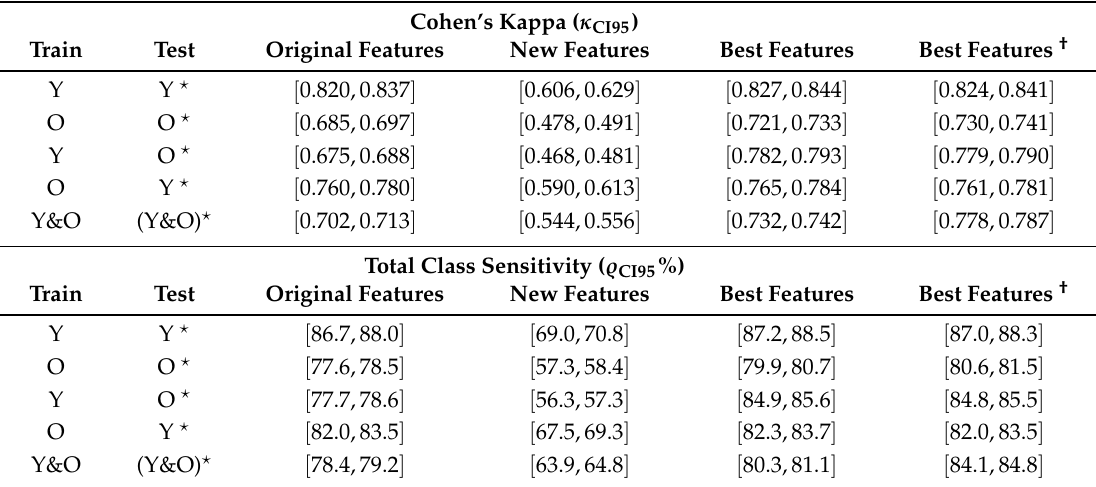
Table 3. Ninety-five percent confidence intervals for the Cohen’s Kappa and total class sensitivity when hierarchical models for human activity recognition were developed with different